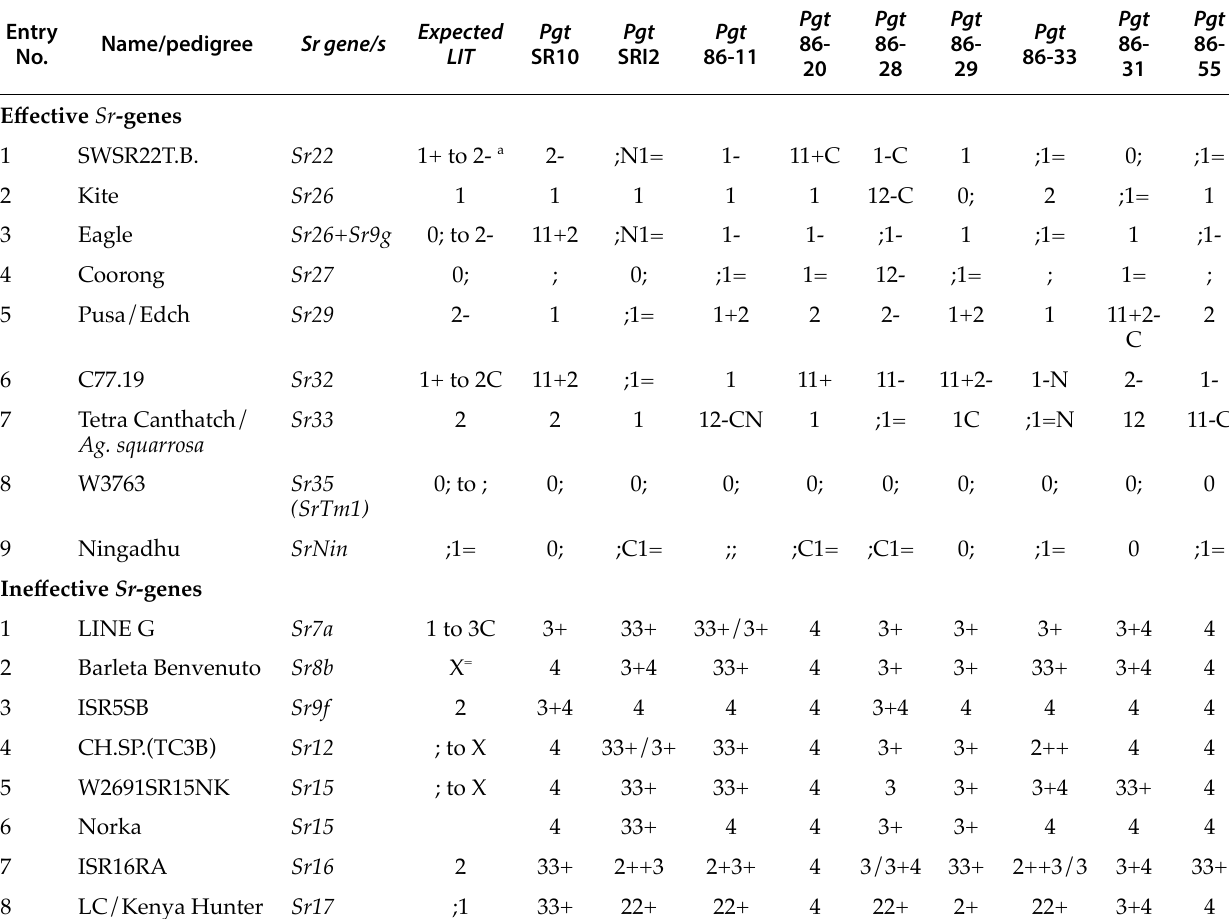
Table 5. Expected low infection types (LITs) of stem rust resistance gene and reaction of stem rust differential lines when inoculated with nine Puccinia graminis f. sp. tritici collections Entry